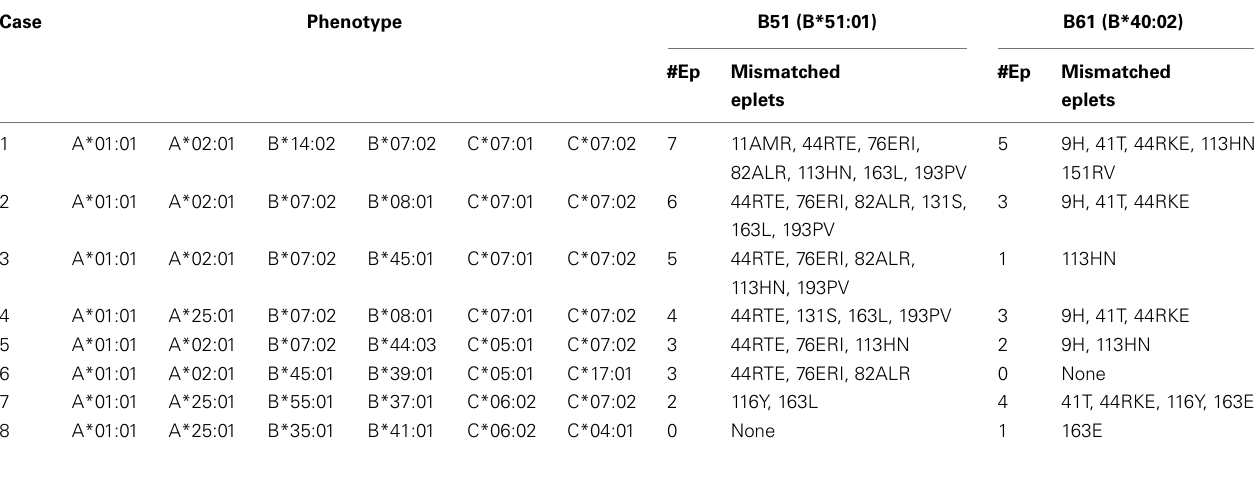
Table 1 |Two examples showing how the HLA phenotype of the recipient affects the eplet load of a class I allele mismatch (Adapted from Duquesnoy,